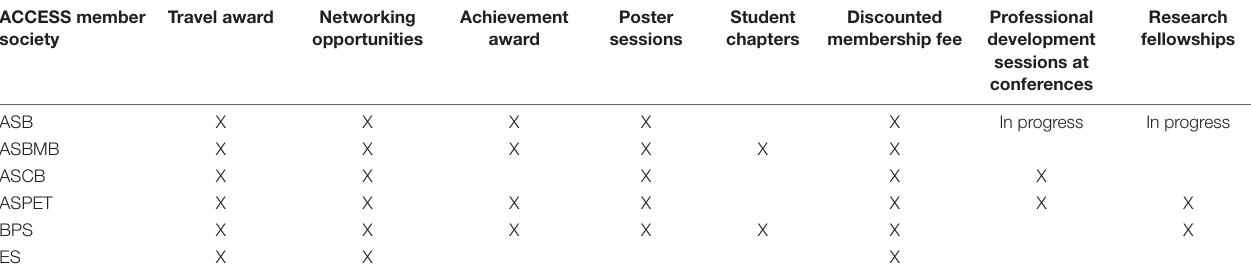
TABLE 2 | Summary of undergraduate membership, dues and student chapters in ACCESS member societies as of summer 2021. ACCESS member society